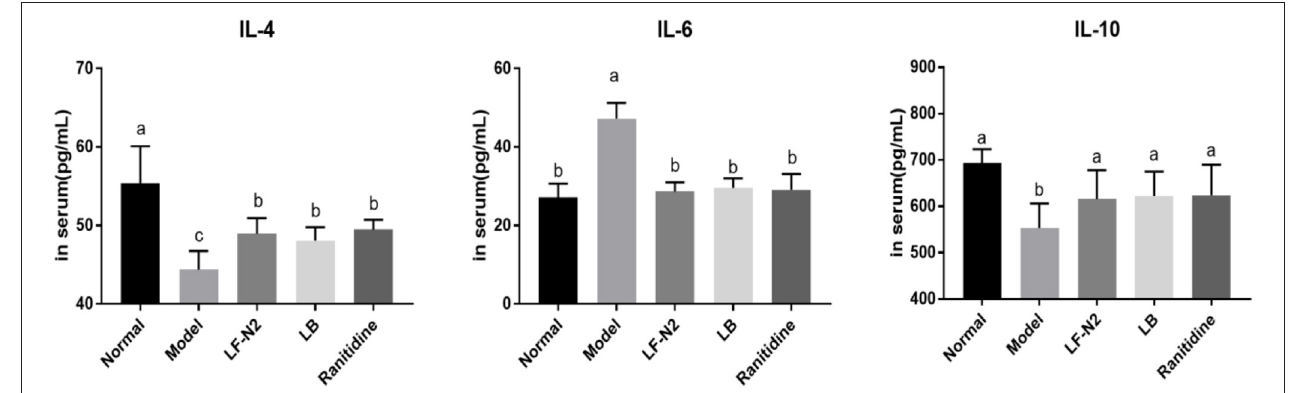
FIGURE 6 | mRNA expression in gastric tissue of mice with with HCl/ethanol-induced gastric injury. LF-N2, Lactobacillus fermentum TKSN02 (1 × 10 9 CFU//kg); LB, Lactobacillus bulgaricus (1 × 10 9 CFU/kg); ranitidine (200 µ g/g). a − c Mean values with different letters in the same bars are significantly different ( P < 0.05).